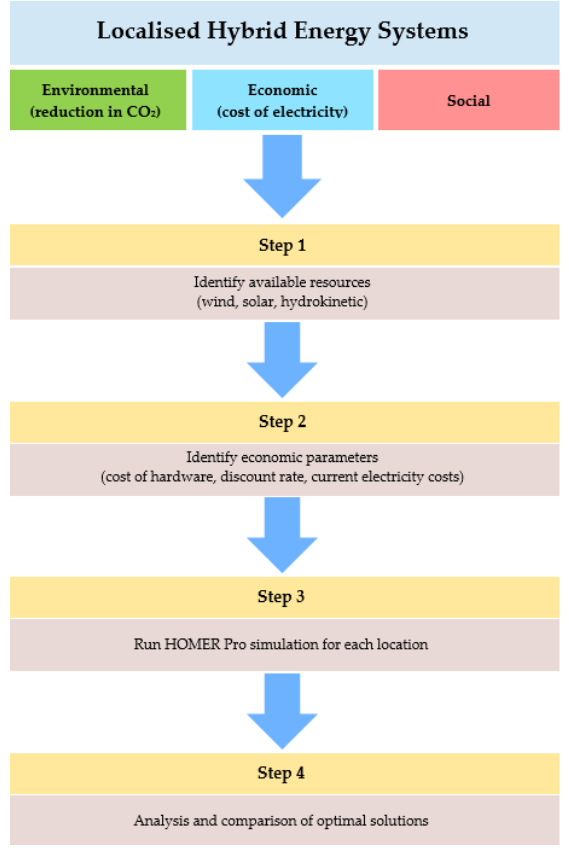
Chart 1. Summary flowchart of methodology.